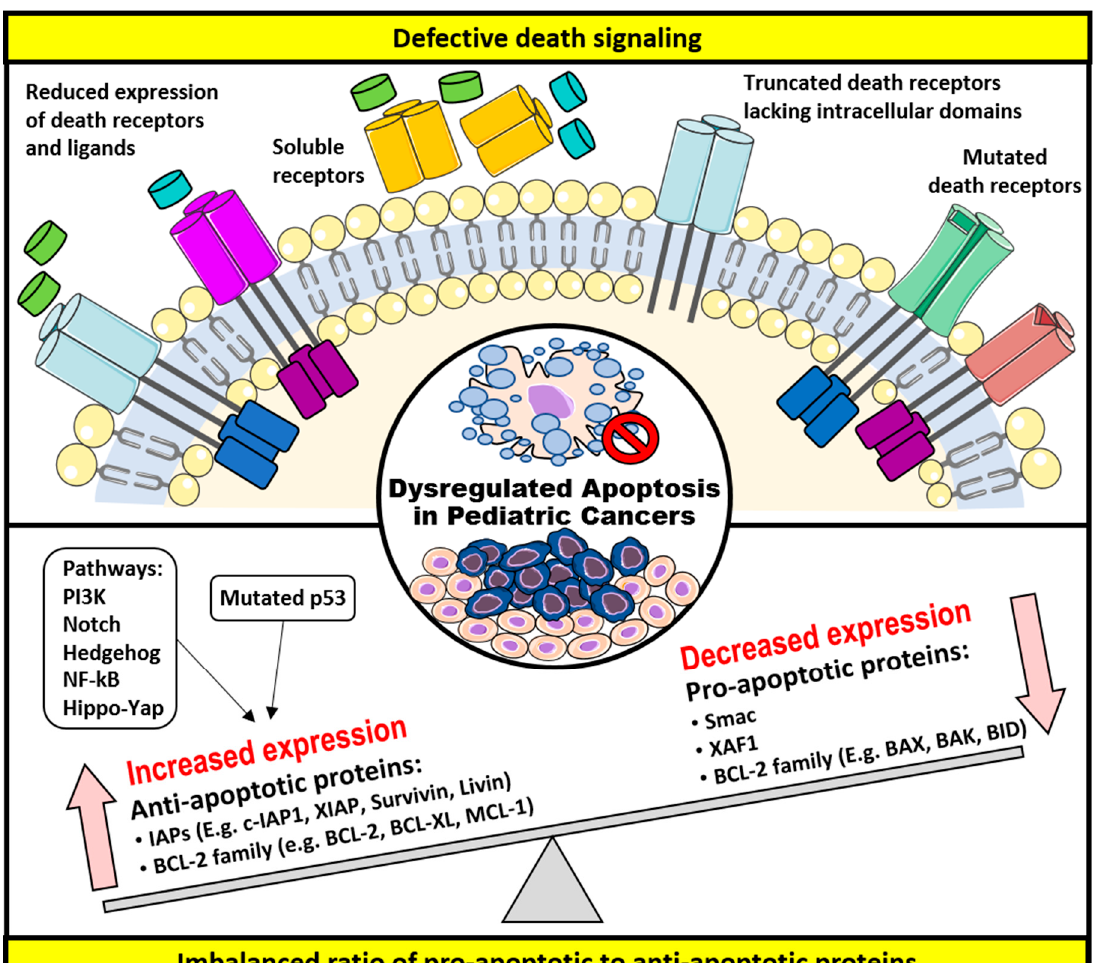
Figure 2. Mechanisms of apoptotic evasion in pediatric cancers and therapeutic targets.